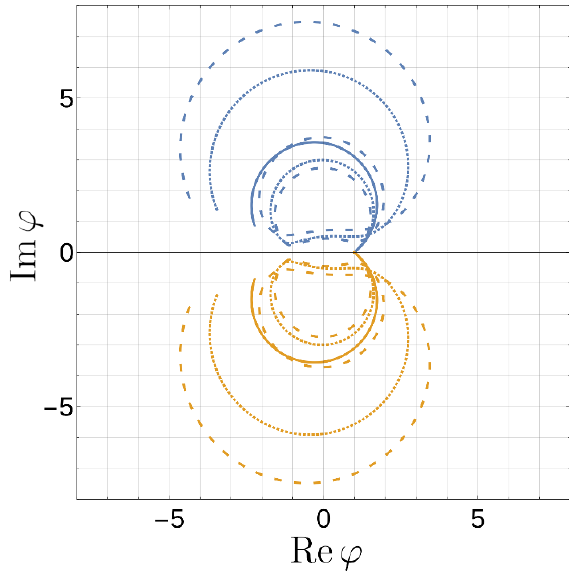
Figure 2 . Trajectories in the complex ’ plane of the solutions of eq. (3.3) associated to the three leading saddles (blue) and their complex conjugates (orange). In increasing order of represented by continuous, dotted and dashed curves. All trajectories start for (cid:26) = 0 in three di(cid:11)erent points of the complex plane with zero velocities value ’ ( ) = 1